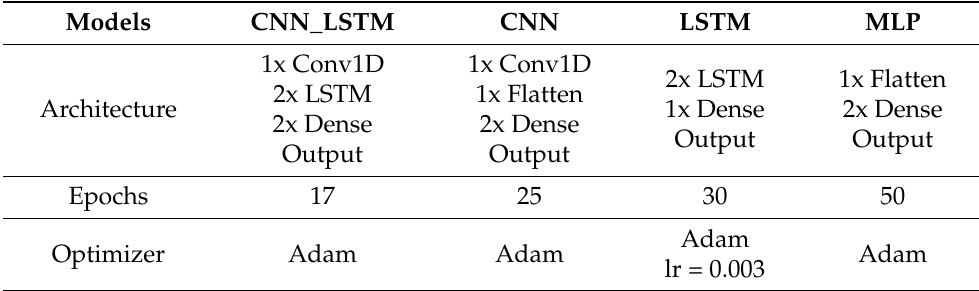
Table 6. Models parameters &